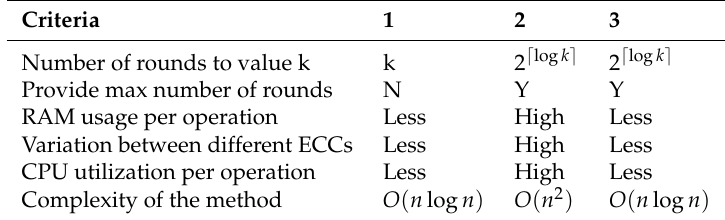
Table 2. The comparison between mapping